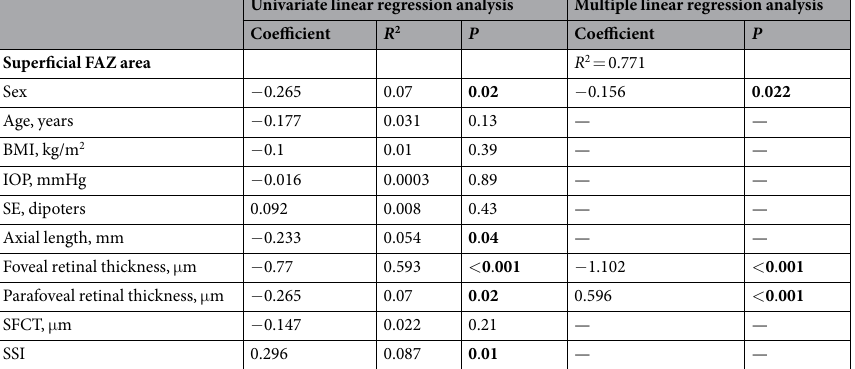
Table 5. Linear regression analysis of factors affecting the superficial FAZ